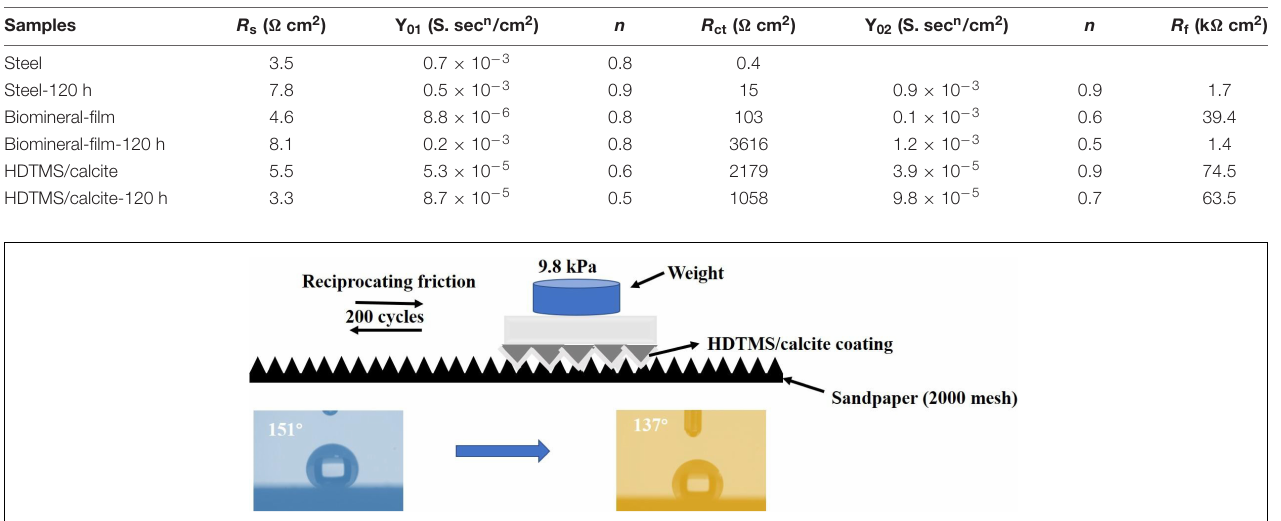
FIGURE 11 | Schematic illustrations of micro-/nano-structure of the HDTMS/calcite coating acting as a solid lubricant during the abrasion by sandpaper (2000 mesh).